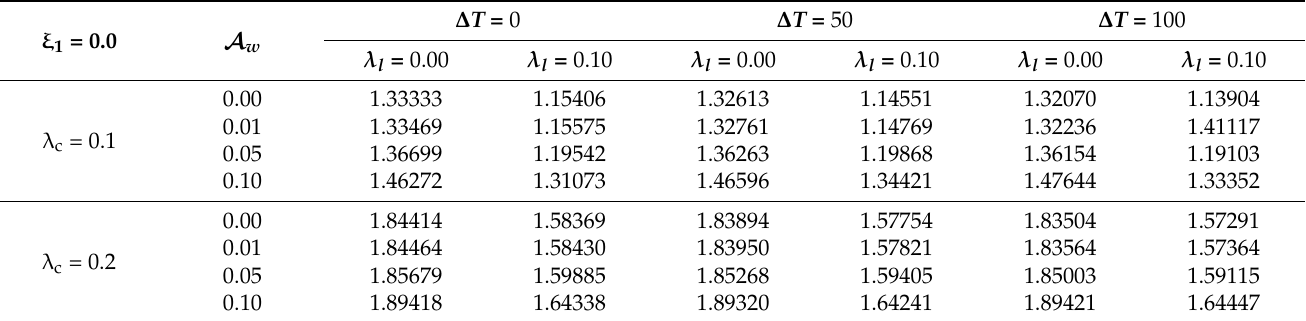
Table 12. Nonlinear dimensionless natural frequencies of porous FG clamped–clamped (C–C) nano- beam for ξ 1 = 0.0 in the case of Second-Order Hamiltonian Approach.